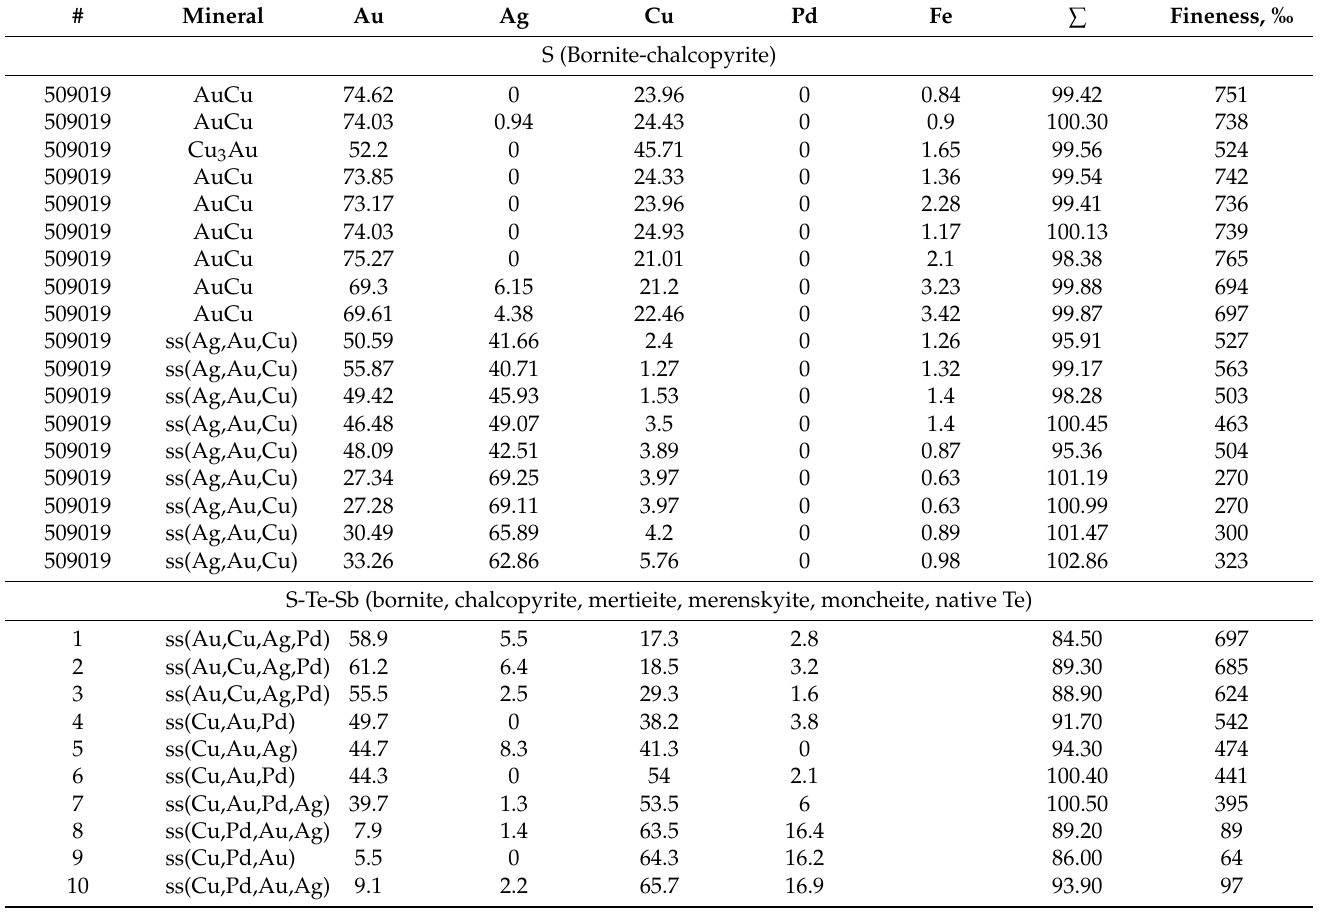
Table 14. Chemical composition of native gold at Ozernoe occurrence from